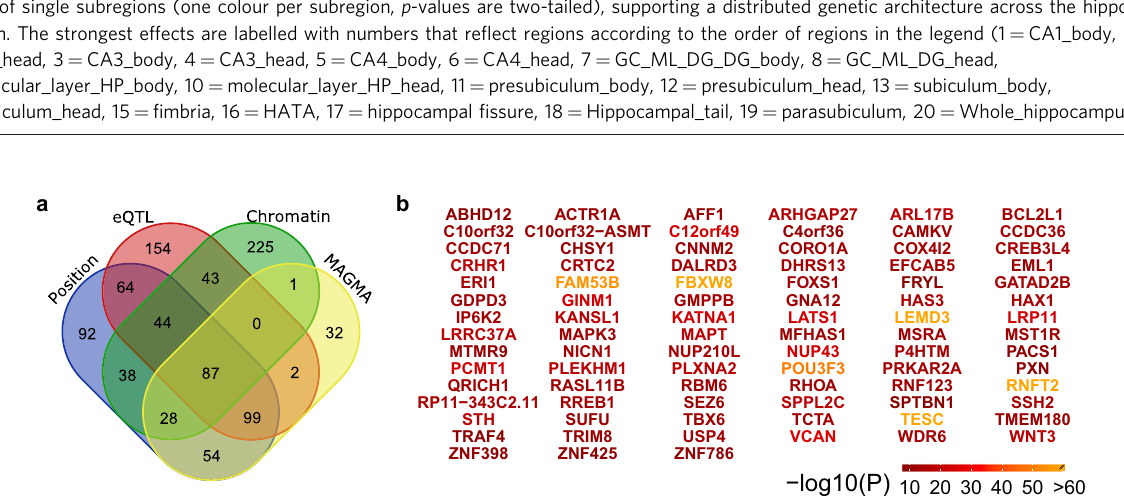
Fig. 1 The multivariate framework discovered 177 independent loci signi fi cantly associated with the hippocampal formation. a Schematic illustration of the hippocampus regions. The hippocampal formation comprises the histologically distinguishable sub fi elds of the hippocampus proper as well as the dentate gyrus with its own sub fi elds, and the neocortical subiculum, presubiculum and parasubiculum. In all but the latter, the hippocampal formation is also divided into an anterior (head) and a posterior part (body). b The upper part illustrates the − log 10 ( P ) statistic from the multivariate GWAS across the entire formation, with 177 signi fi cant loci. The lower part depicts for each of the 177 unique loci the corresponding − log 10 ( P ) statistics from univariate GWASs of single subregions (one colour per subregion, p -values are two-tailed), supporting a distributed genetic architecture across the hippocampal formation. The strongest effects are labelled with numbers that re fl ect regions according to the order of regions in the legend (1 = CA1_body,